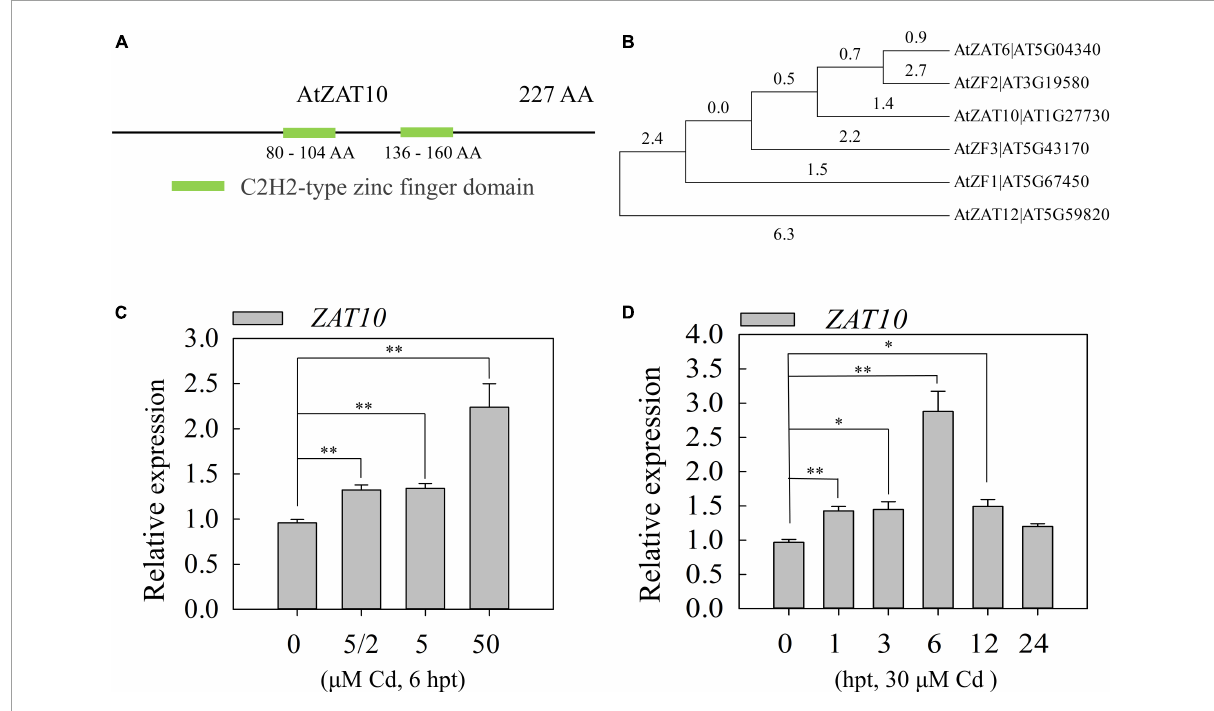
FIGURE1 Molecular characterization of ZAT10 and the expression patterns of ZAT10 under cadmium stress. (A) The sites of the predicted two C2H2-type zinc-finger domains in the ZAT10 protein. (B) Phylogenetic tree of ZAT10 and its homologous members in Arabidopsis . (C,D) Relative expression levels of ZAT10 in 5-day-old wild type seedlings (C) under CdSO 4 (0, 2.5, 5, and 50 µ M) treatment for 6 h and (D) at 0, 1, 3, 6, 12, 24 h post treatment (hpt) with 30 µ M CdSO 4 . Means ± SD, n = 3; ∗ P < 0.05 or ∗∗ P < 0.01, Student’s t